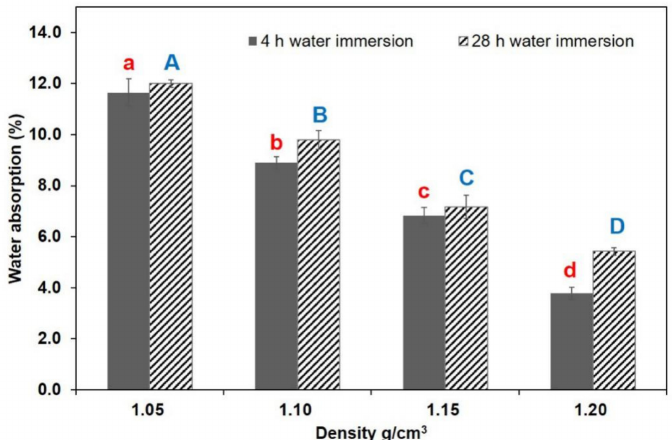
Figure 6. Width swelling results at different hot press temperatures (Notes: The same lowercase (4 h water immersion) and capital letter (28 h water immersion) are not significantly different at 5% significance level using Duncan’s post-hoc test).